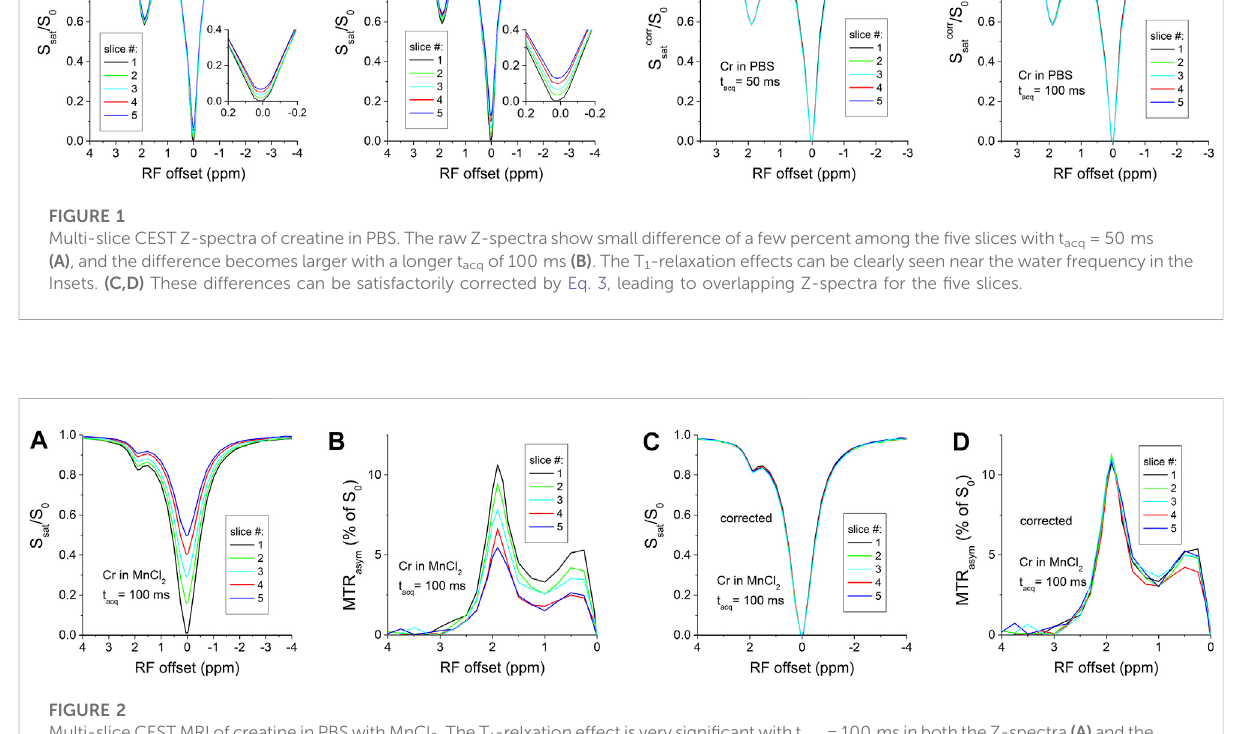
Multi-sliceCESTMRIofcreatineinPBSwithMnCl 2 .TheT 1 -relxationeffectisverysigni fi cantwitht acq =100 msinboththeZ-spectra (A) andthe MTR asym spectra (B) , which can be satisfactorily corrected by Eqs 3, 6, respectively, leading to overlapping spectra for the fi ve slices (C,D)